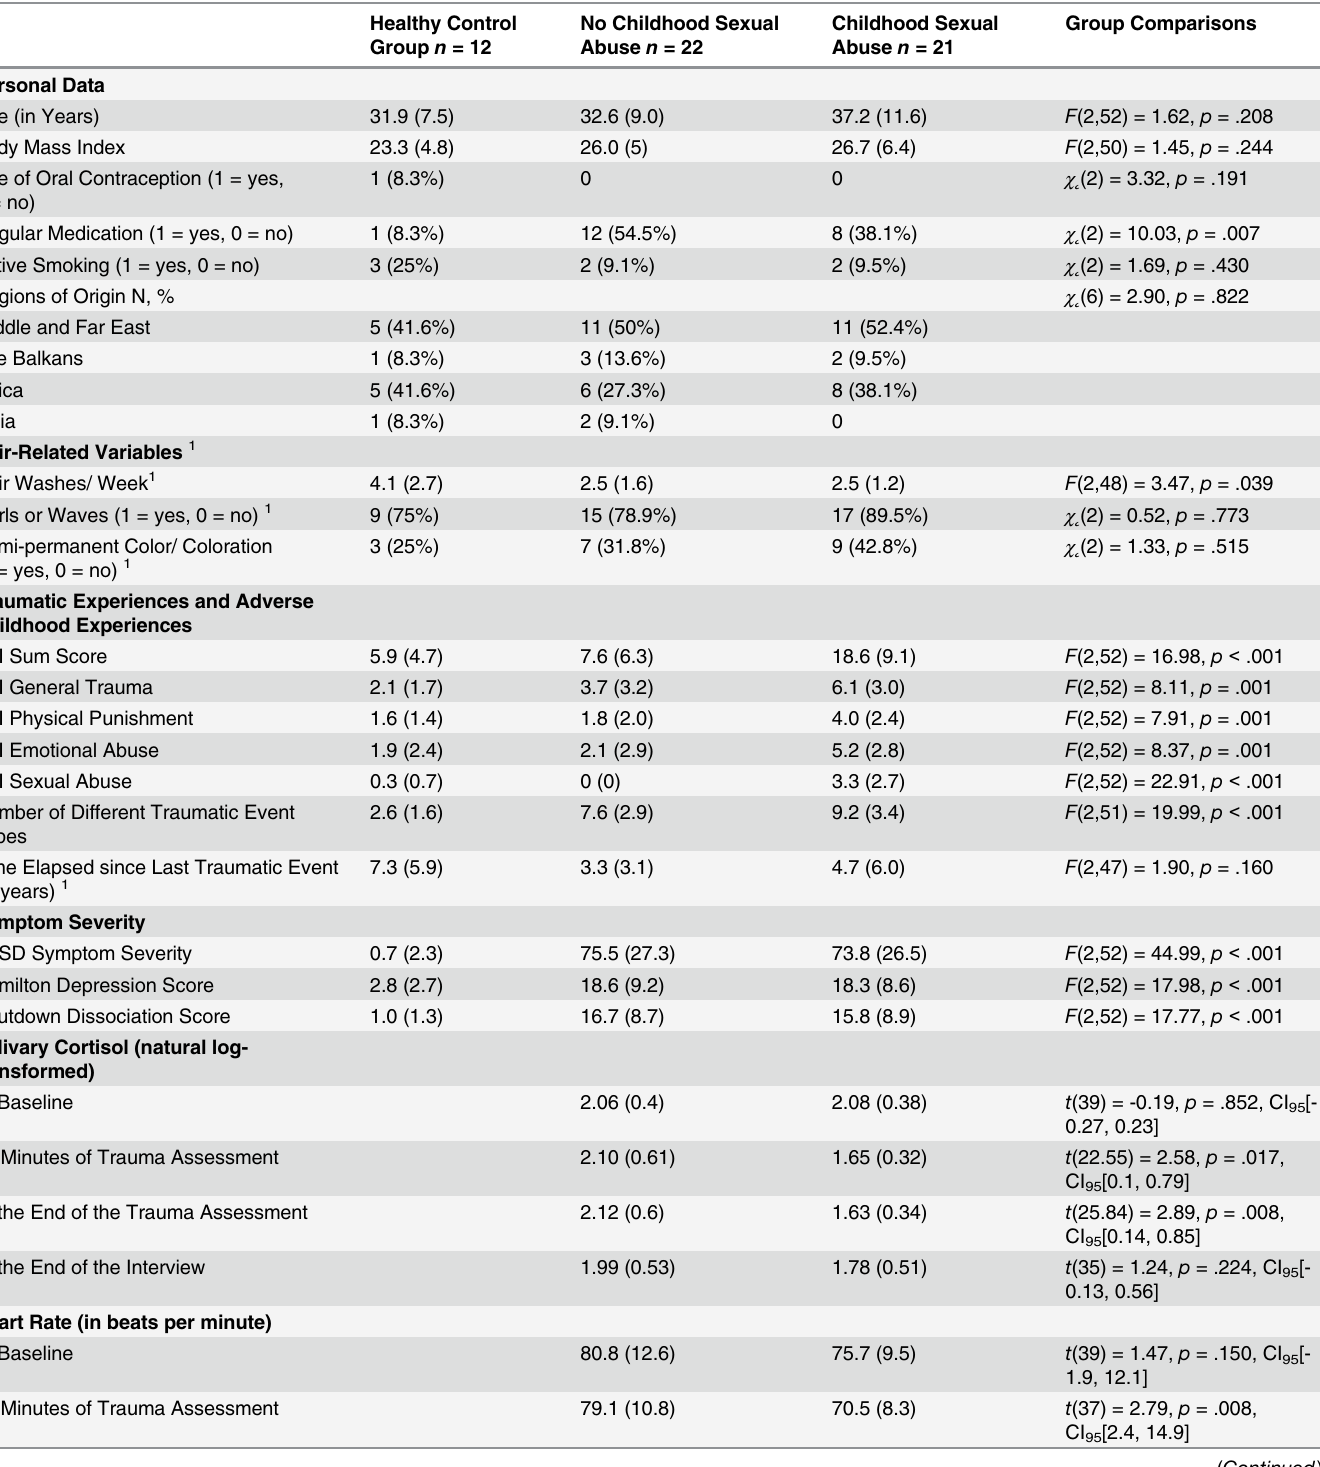
Table 1. Demographic Data, Hair-related Variables and Clinical Data for the Patient Group and the Healthy Control Group. Results of Saliva Cortisol and Heart